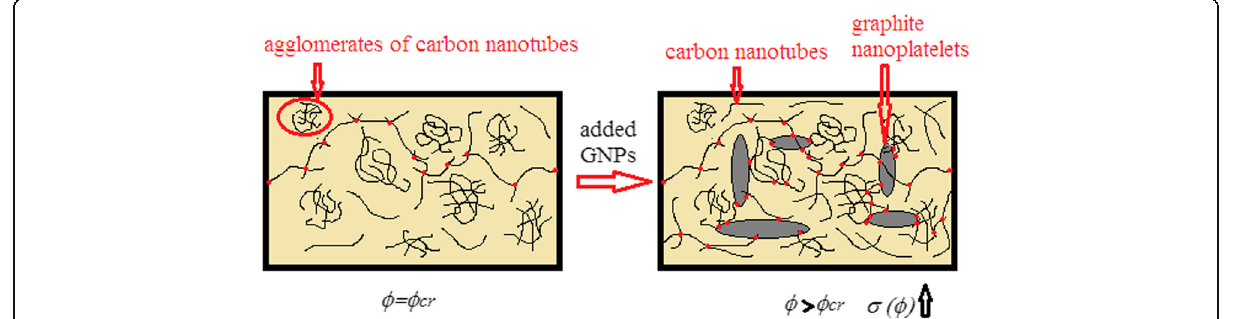
Fig. 5 Principles of conductive pathway formation in hybrid CM –